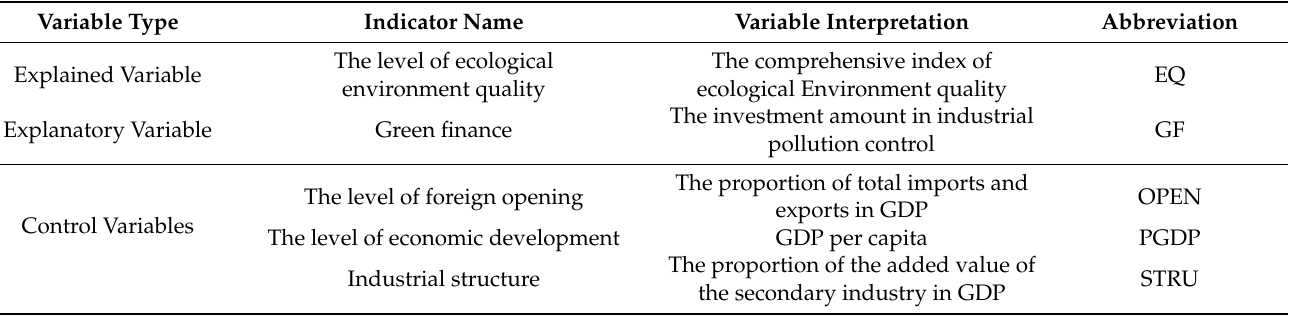
Table 2. Variable description.